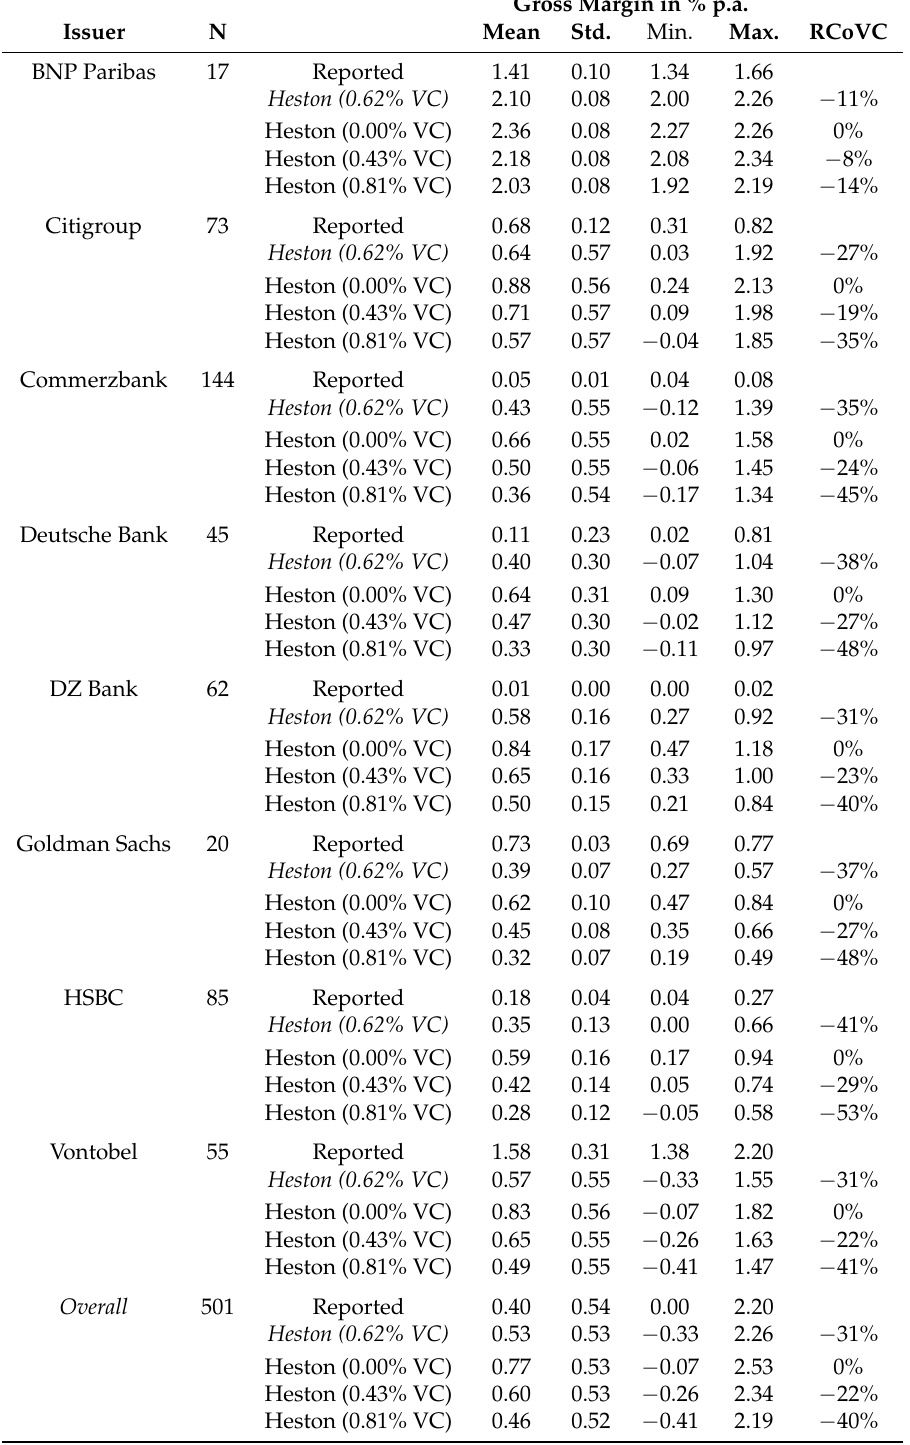
Table 5. Impact of Hedging Costs on Heston Margins (Discount Certificates). Gross Margin in %